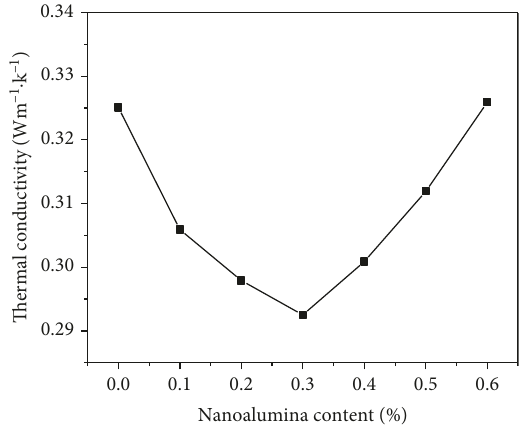
Figure 9: Effect of nano-Al 2 O 3 to thermal conductivity of gypsum boards with the OD/EP